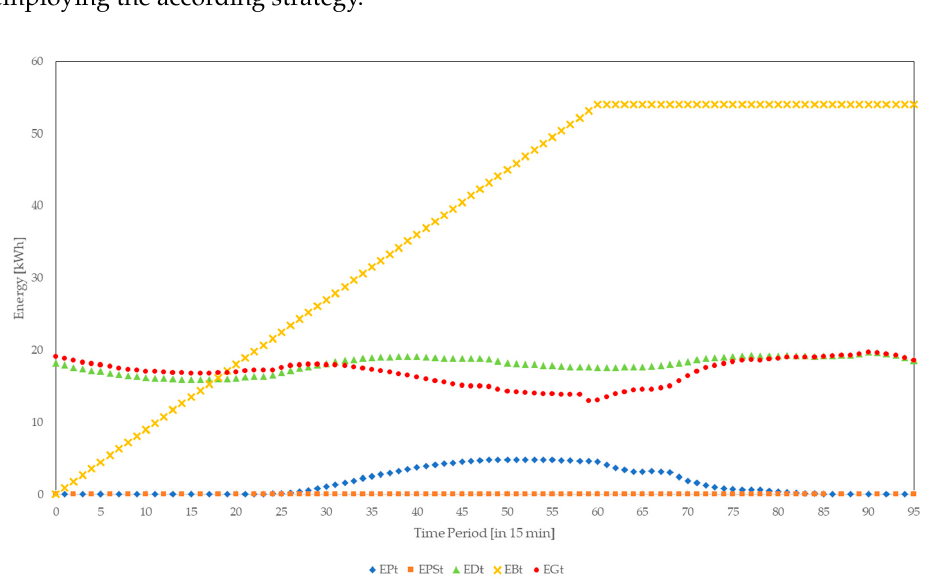
Figure 11. Graphic analysis of the effects of a confidentiality attack on grid energy price.